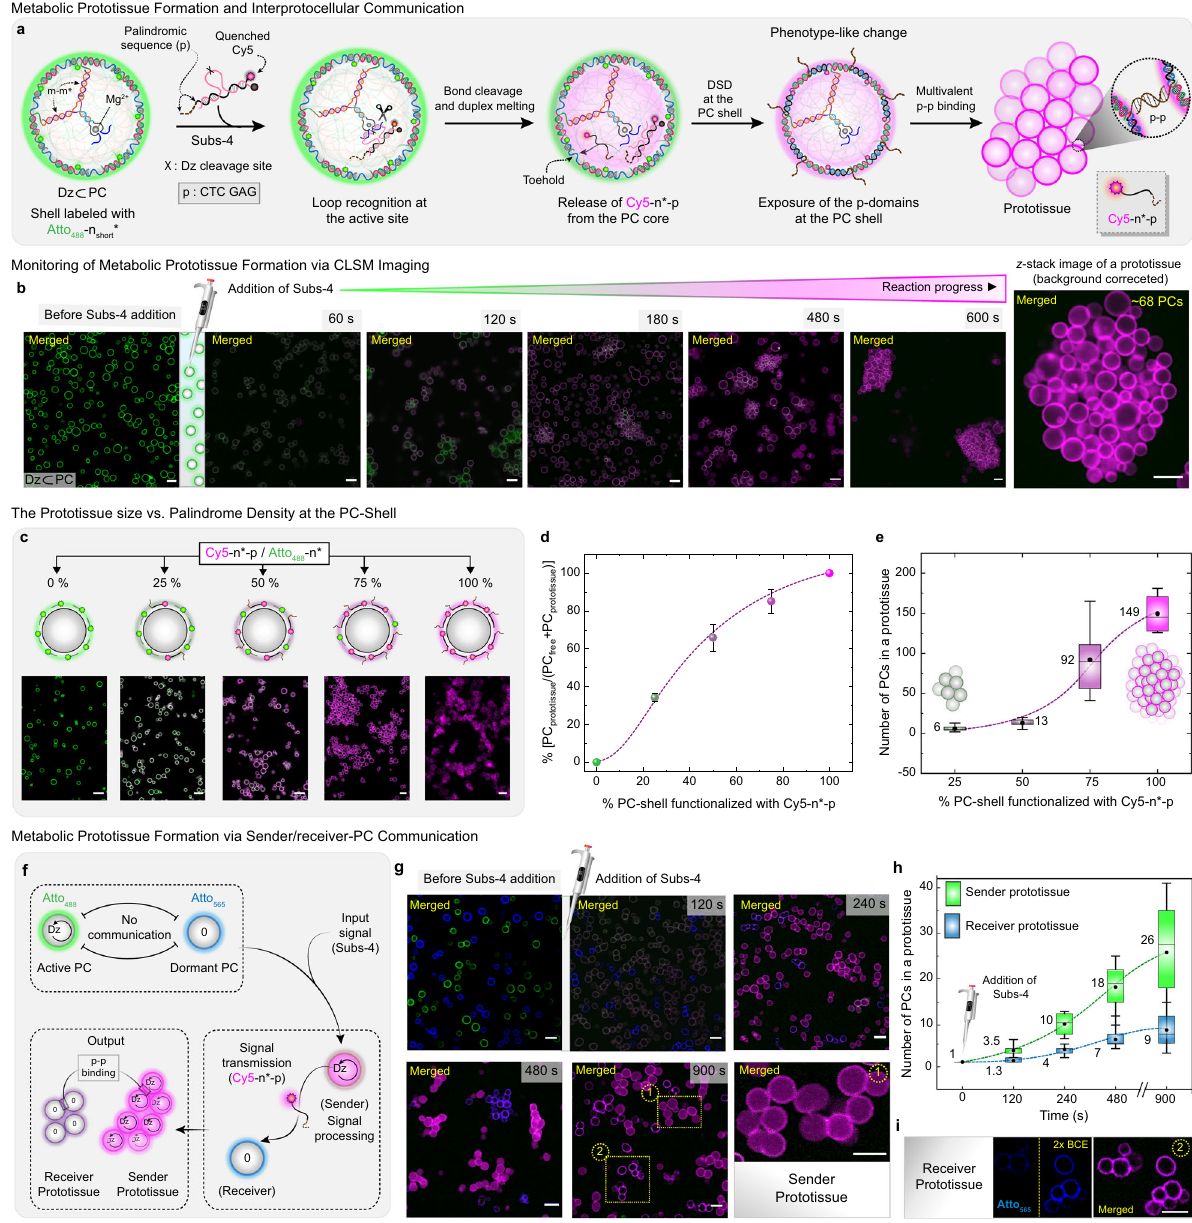
Fig. 5 Metabolic bond cleavage and downstream prototissue formation via establishing interprotocellular communication. a Schematic representation of a downstream cascade, DCBC → BCDM → DSD reaction at PC shell → multivalent palindromic interprotocellular duplex formation, using Subs-4 as an input signal. b The time-dependent CLSM image of Atto 488 -n short *-labeled Dz ⊂ PCs before and after the addition of Subs-4. At t = 10min, the CLSM image represents a prototissue ( ∼ 68 PCs) built upon multivalent p – p* interactions. c Illustration and CLSM images of prototissues from fi ve PC-mixtures, in which the palindromic- density at the PC shell is varied from 0 → 100%. Merged channels represent Atto 488 (green) and Cy5 (magenta) fl uorescence. d , e statistical distribution of PC prototissue number fraction and size of the prototissue as a function of palindromic-density at PC shell. f Schematic illustration of downstream interprotocellular signal transduction and the growth of sender and receiver prototissues in a mixture containing active Atto 488 -n short *-labeled (green) PCs (Dz ⊂ PCs), and the dormant Atto 565 -n short *-labeled (blue) PCs. g Time-dependent CLSM images of interprotocellular communication and growth of prototissues in a mixed-PC system. A gradual increase of magenta fl uorescence is observed at the shell of the active green PCs substituting the green fl uorescence leading to the formation of sender prototissue. The shell color of dormant PCs changes to pink following the receiver prototissue formation within 4min Subs-4 addition. The merged channel represents Atto 488 (green), Atto 565 (blue), and Cy5 (magenta) fl uorescence. h Time-dependent growth of sender and receiver prototissues. i The zoomed-in images of two receiver prototissues (blue and merged channel). BCE represents brightness and contrast enhancement. The error bar in d represents the standard deviation of two different sample means at a particular palindromic-density ( N = 358 PC-counts over two samples). For e , h the mean and the median line over the prototissue population are represented inside the box. The box represents the fi ve-number summary of the PC prototissue date set and is extended from the fi rst quartile to the third quartile. The whiskers represent the standard deviation of ten prototissue counts. The dotted lines are a guide to the eye. The scale bar = 5 μ m. Condition: [Dz ⊂ PCs] = 5 μ M, [Subs-4] = 35 μ M in TE buffer at 35°C.